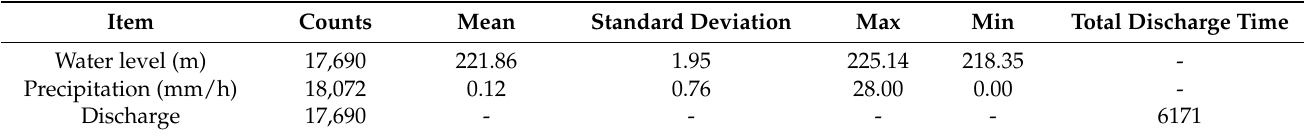
Figure 3. Water levels during the study. Table 4. Summary of data obtained from Takayama Reservoir during the study.